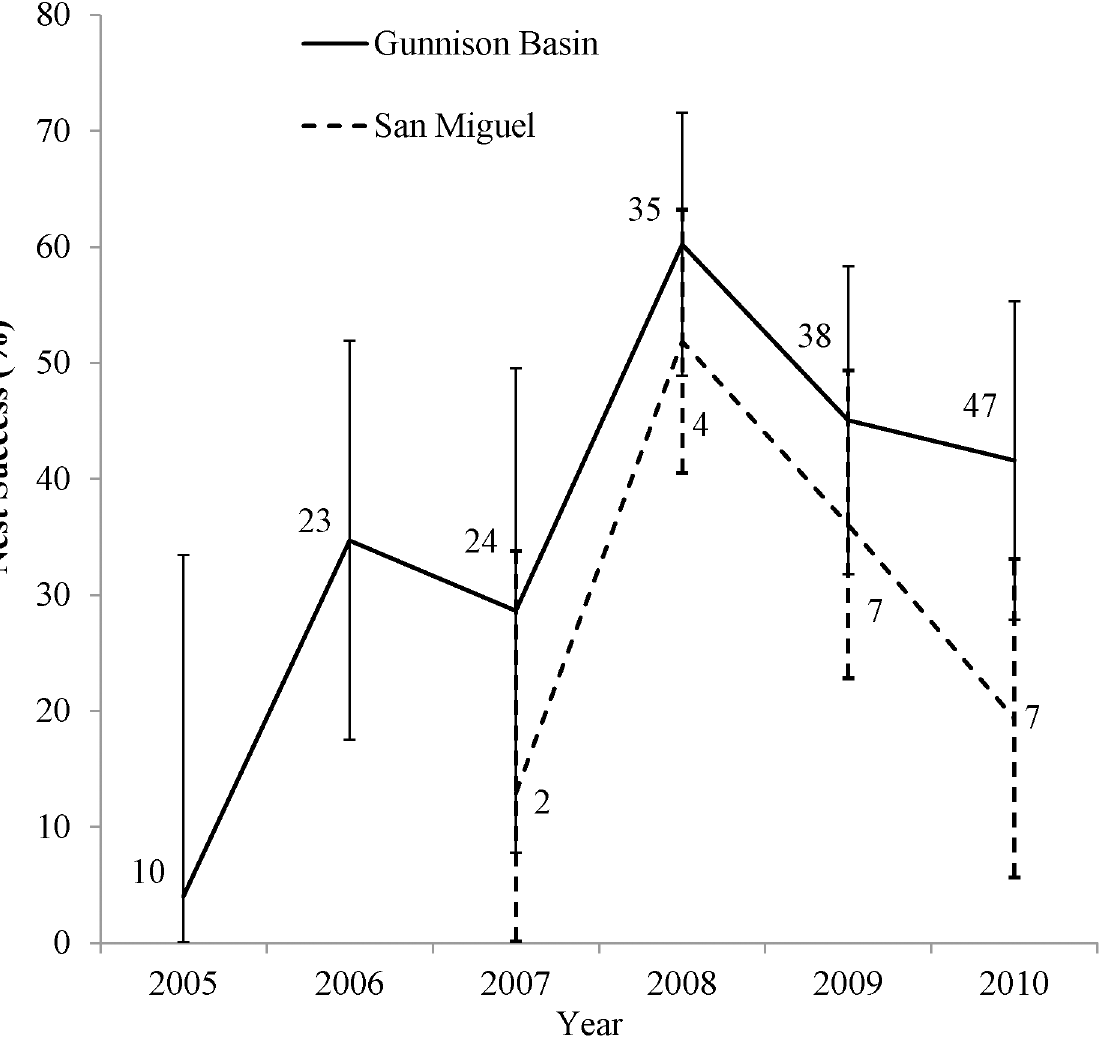
Fig 2. Nest success rates (%) for Gunnison Sage-Grouse. Nest success estimates by year (2005 – 2010) and population (Gunnison Basin and San Miguel) for Gunnison Sage-Grouse in Colorado, USA, with 95% confidence intervals. The estimates are based on model averaging and sample sizes are by